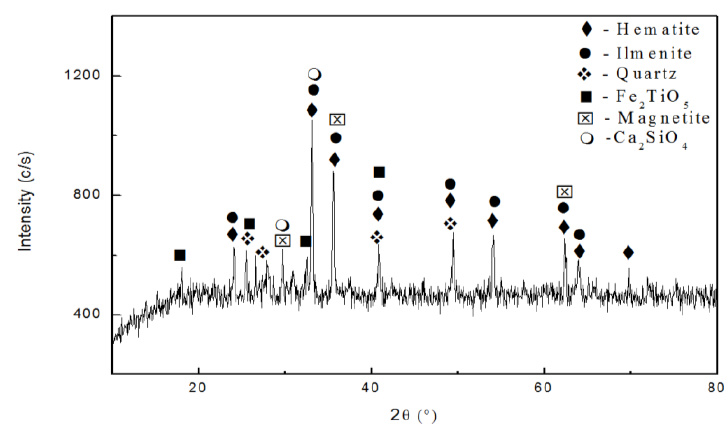
Figure 1. X-ray di ff ractogram for the titaniferous sand. Figure 1. X-ray diffractogram for the titaniferous sand. Figure 1. X-ray diffractogram for the titaniferous sand.